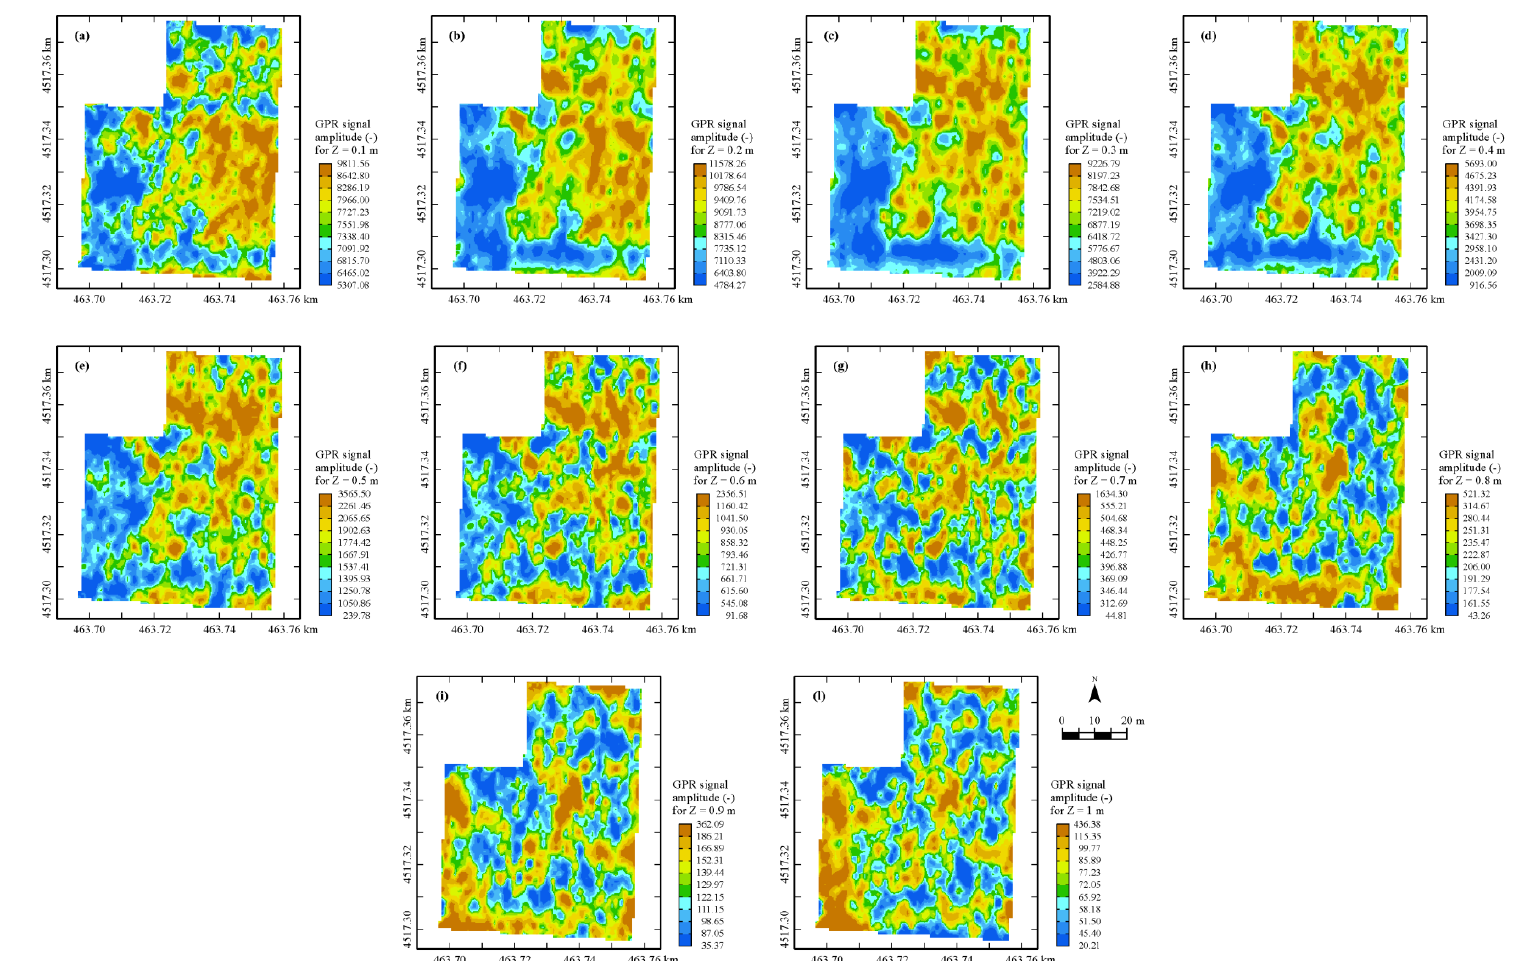
Figure 5. Maps of horizontal sections of estimated GPR signal amplitude envelope. Only a selection up to 1 m of the horizontal sections ( a–l ) are reported. Color scale uses iso-frequency classes.